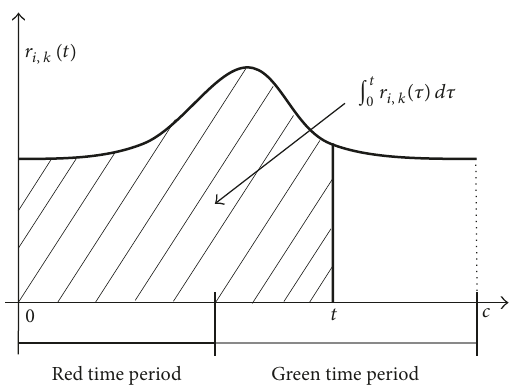
Figure 2: Typical saturation flow and cumulative discharges (in number of vehicles or pcu) in an approaching traffic lane under traffic signal controls.